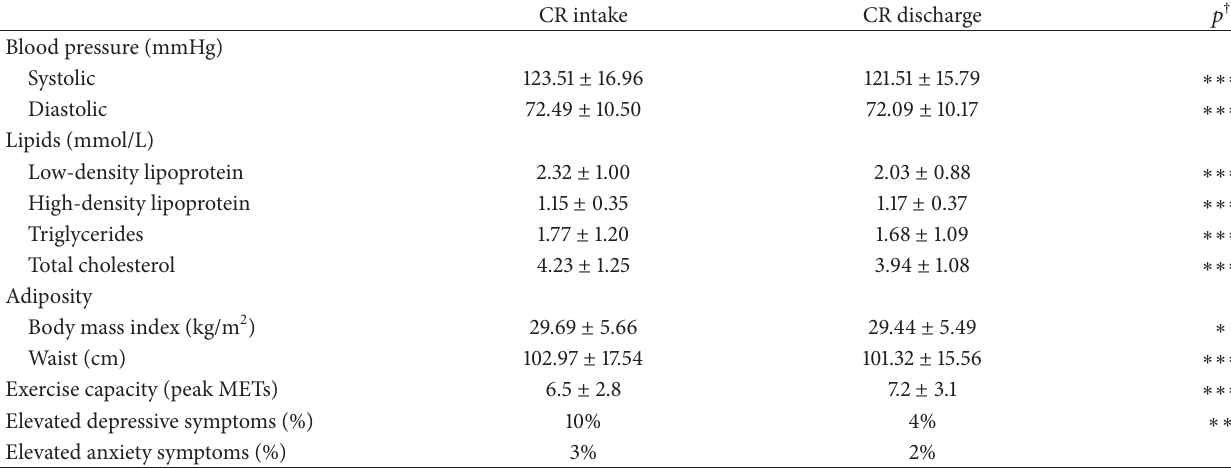
Table 3: Intake to discharge comparisons in outcome measures among patients completing